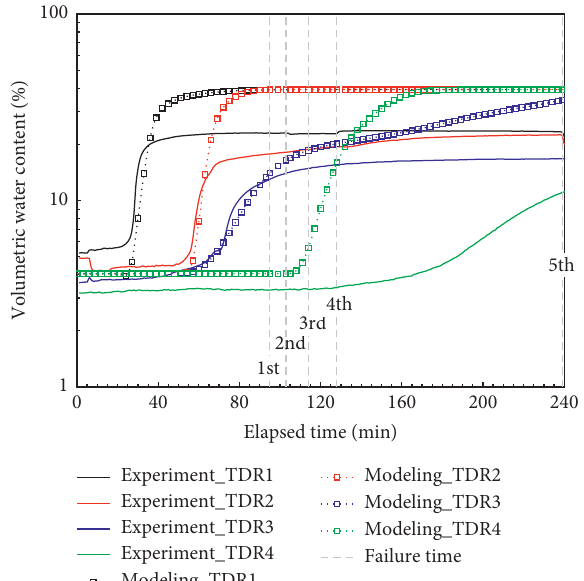
Figure 8: Comparison between the experiment and modeling results in terms of volumetric water content changes with respect to elapsed time at the four TDR sensor locations.